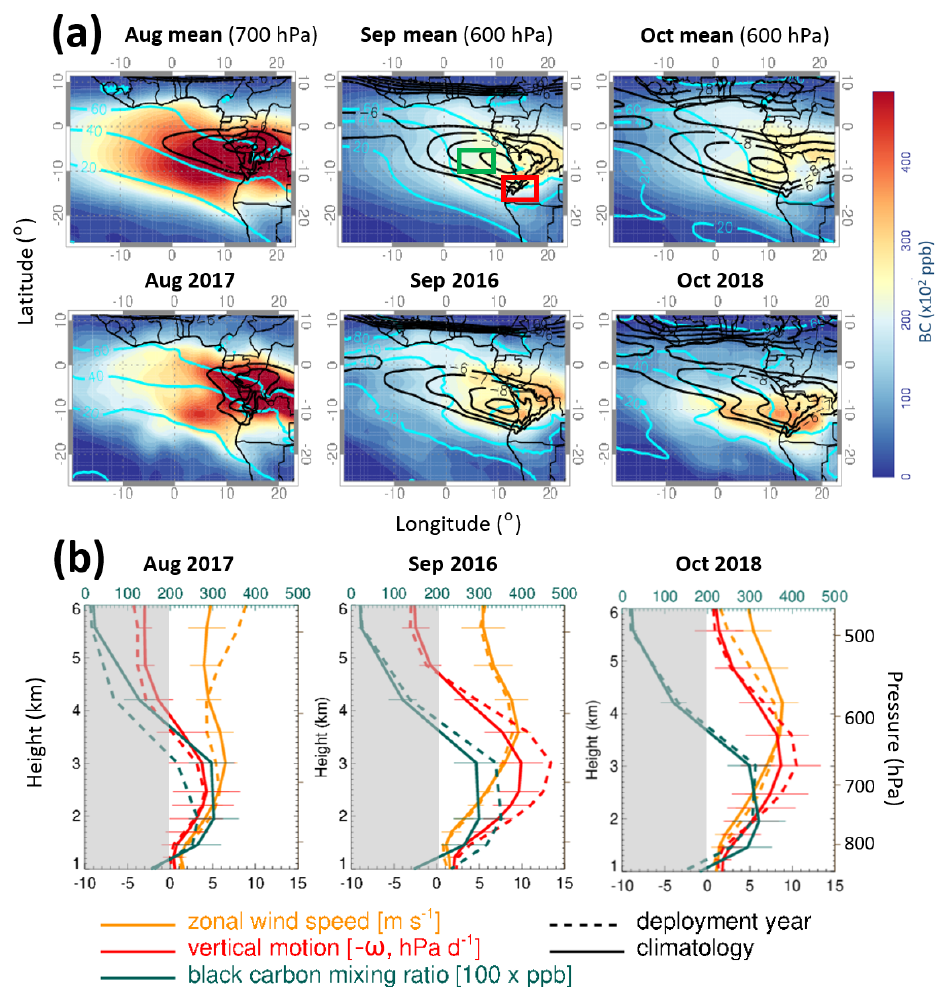
Figure 10. (a) Maps of 700hPa black carbon mixing ratios (BC; 100 × ppb – parts per billion) overlain by ERA5 700hPa zonal wind (black contour; ms − 1 ) and 700hPa RH (cyan contour; percent) for (top row) the climatological mean and (bottom row) August 2017. The same variables, except at 600hPa, are used for September 2016 and October 2018. (b) The vertical profiles of BC (green; averaged over the region (4–10 ◦ E, 5–10 ◦ S); 100 × ppb), vertical velocity (red; omega multiplied by − 1 to represent the positive (negative) value as the